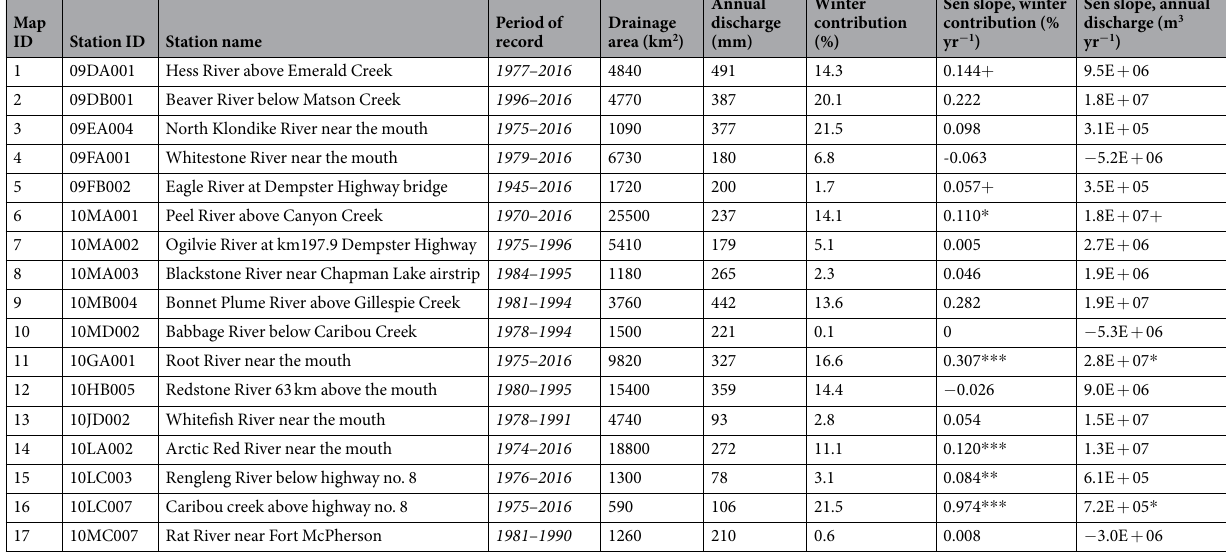
Table 1. Gauging stations in study area, winter contribution to total annual discharge, and trend analysis results. Map ID corresponds to gauging stations on Fig. 1. Level of significance of trend: + (0.1) * (0.05) ** (0.01) ***